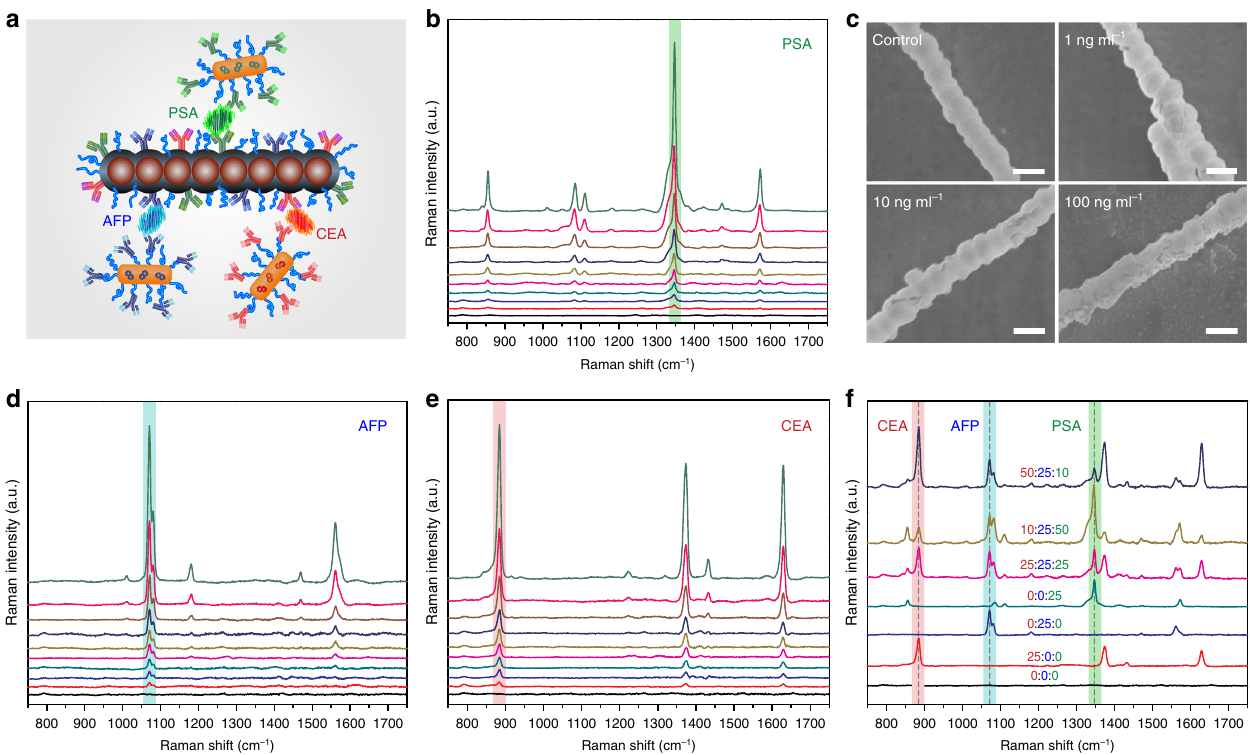
Fig. 3 Multiplexed detection of cancer biomarkers on the MiChip platform. a Conceptual illustration of the simultaneous detection of PSA (green), AFP (blue), and CEA (red). b SERS spectra of different concentrations of PSA in PBS (ranging from 0 to 100 ng ml − 1 ). c SEM images of Magchain-PSA-SERS probes complex formed at varying concentrations of PSA. Scale bar: 500 nm. d , e SERS spectra of AFP and CEA at varying concentrations (ranging from 0 to 100 ng ml − 1 ). f SERS responses to mixtures of the three cancer biomarkers of various